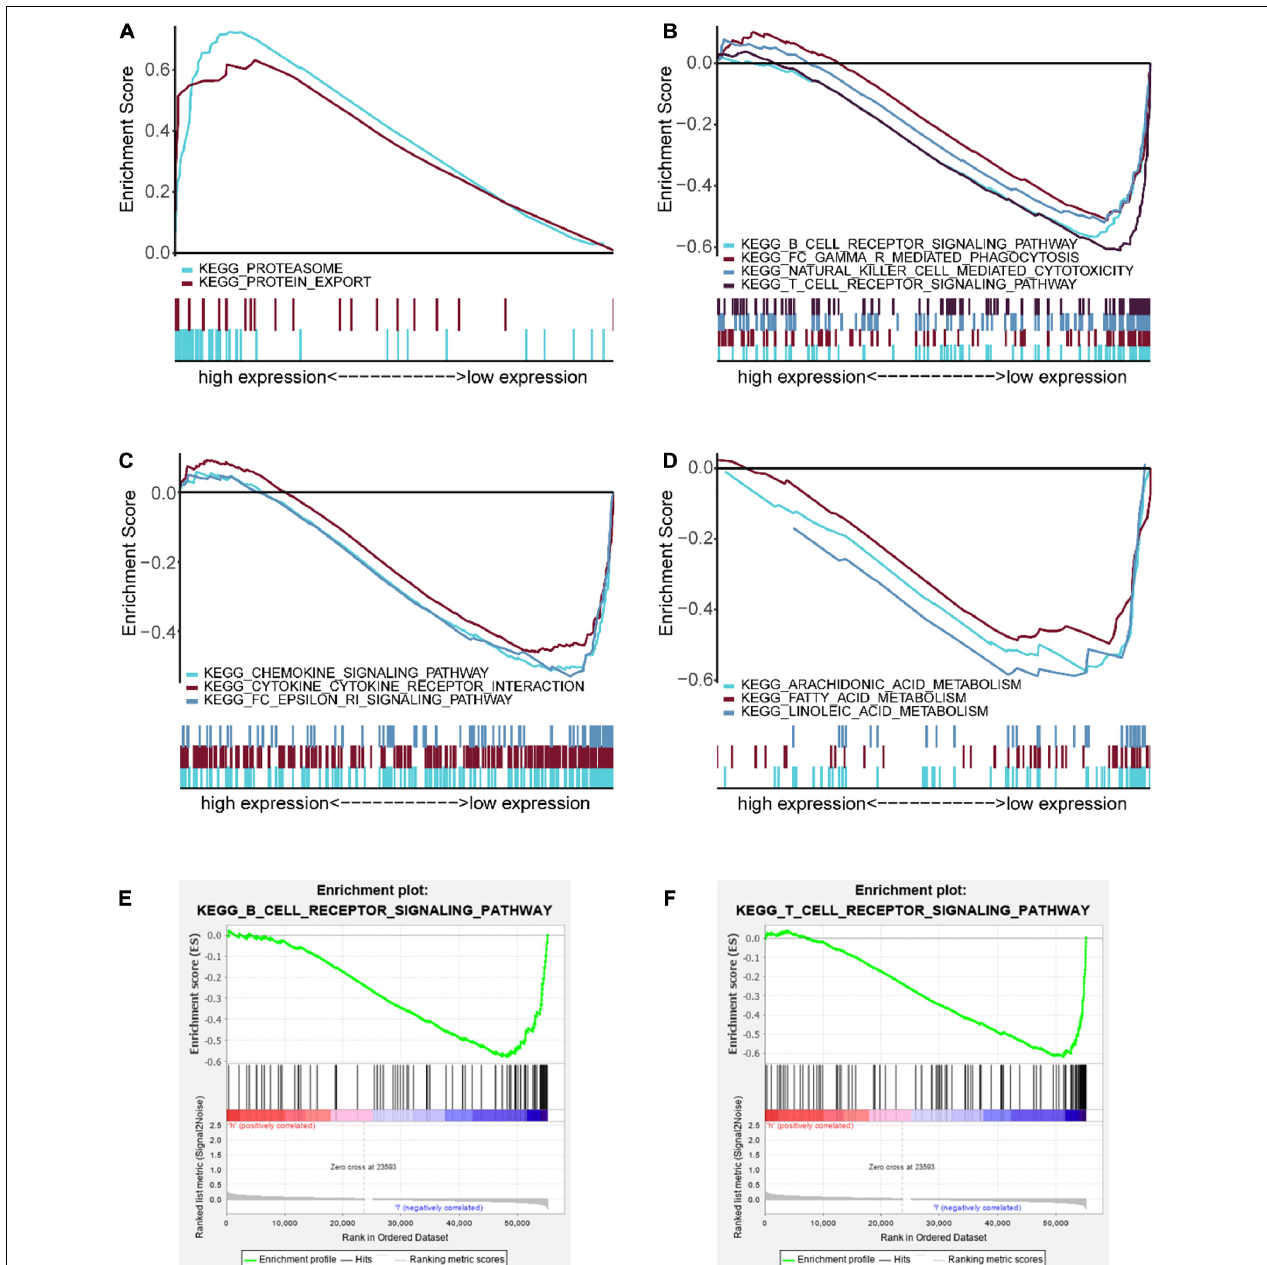
FIGURE 8 | GSEA-enriched pathways of the high-risk and low-risk groups. (A) Multiple GSEA-enriched pathways of the high-risk group: proteasome and protein export. (B) Multiple GSEA for immune-related pathways of the low-risk group: B cell receptor signaling pathway, Fc gamma R-mediated phagocytosis, natural killer cell mediated cytotoxicity, and T cell receptor signaling pathway. (C) Multiple GSEA for inflammatory response-related pathways of the low-risk group: chemokine signaling pathway, cytokine–cytokine receptor interaction, and Fc epsilon RI signaling pathway. (D) Multiple GSEA for fatty acid metabolism-related pathways of the low-risk group: arachidonic acid metabolism, fatty acid metabolism, and linoleic acid metabolism. (E) Single GSEA showing the B cell receptor signaling pathway of the low-risk group. (F) Single GSEA showing the T cell receptor signaling pathway of the low-risk